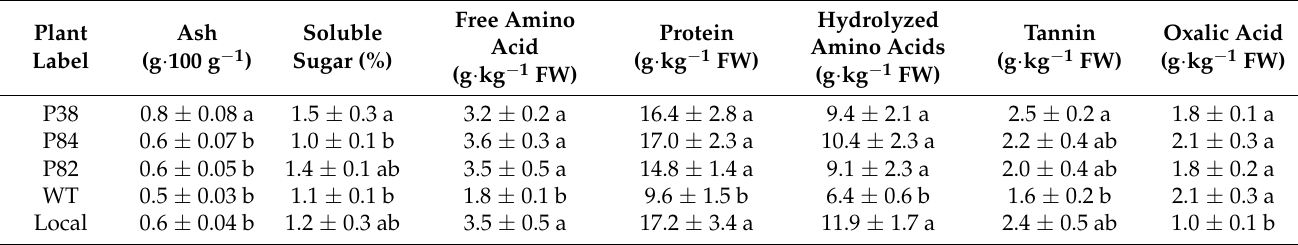
Table 4. Shoots’ nutrient of some D. latiflorus